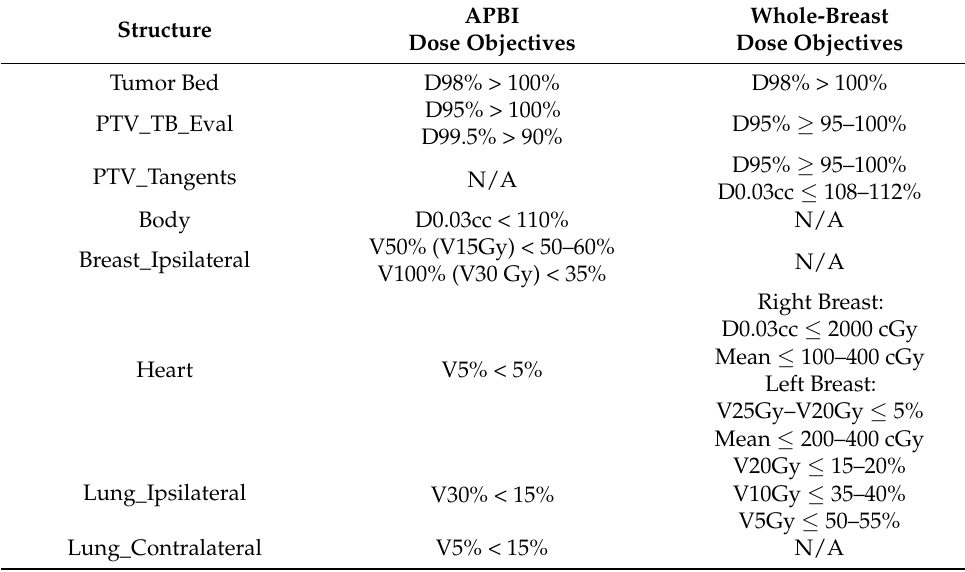
Table 4. Dose objectives for APBI and whole-breast treatment planning